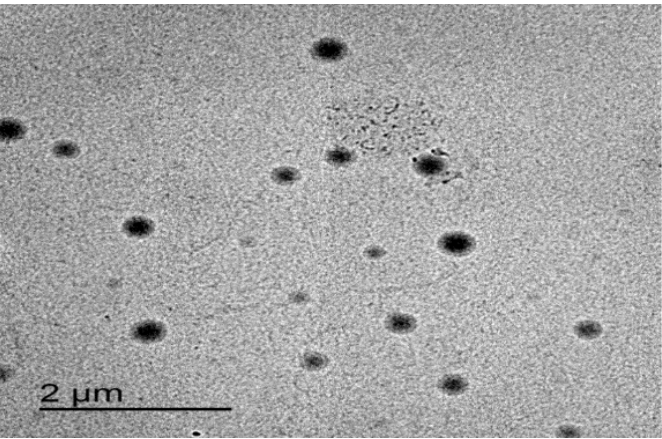
Figure 7. TEM image of the optimized ITZ-TFS4.